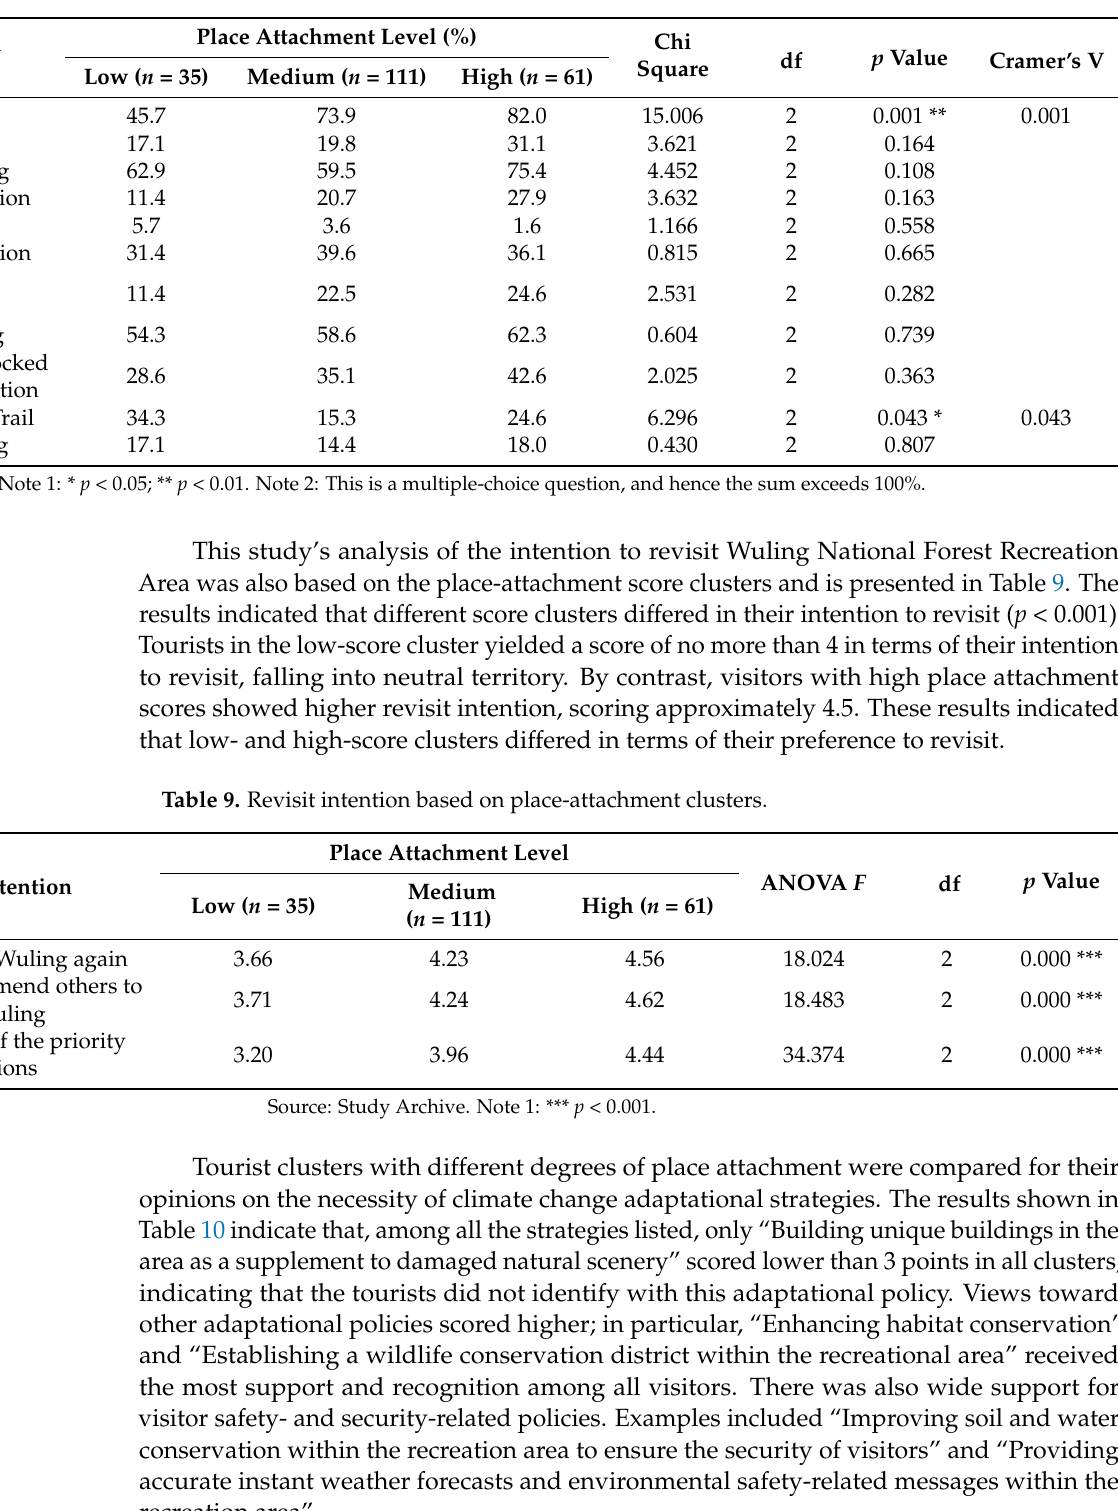
Table 8. Tourist recreation activities based on place-attachment clusters.